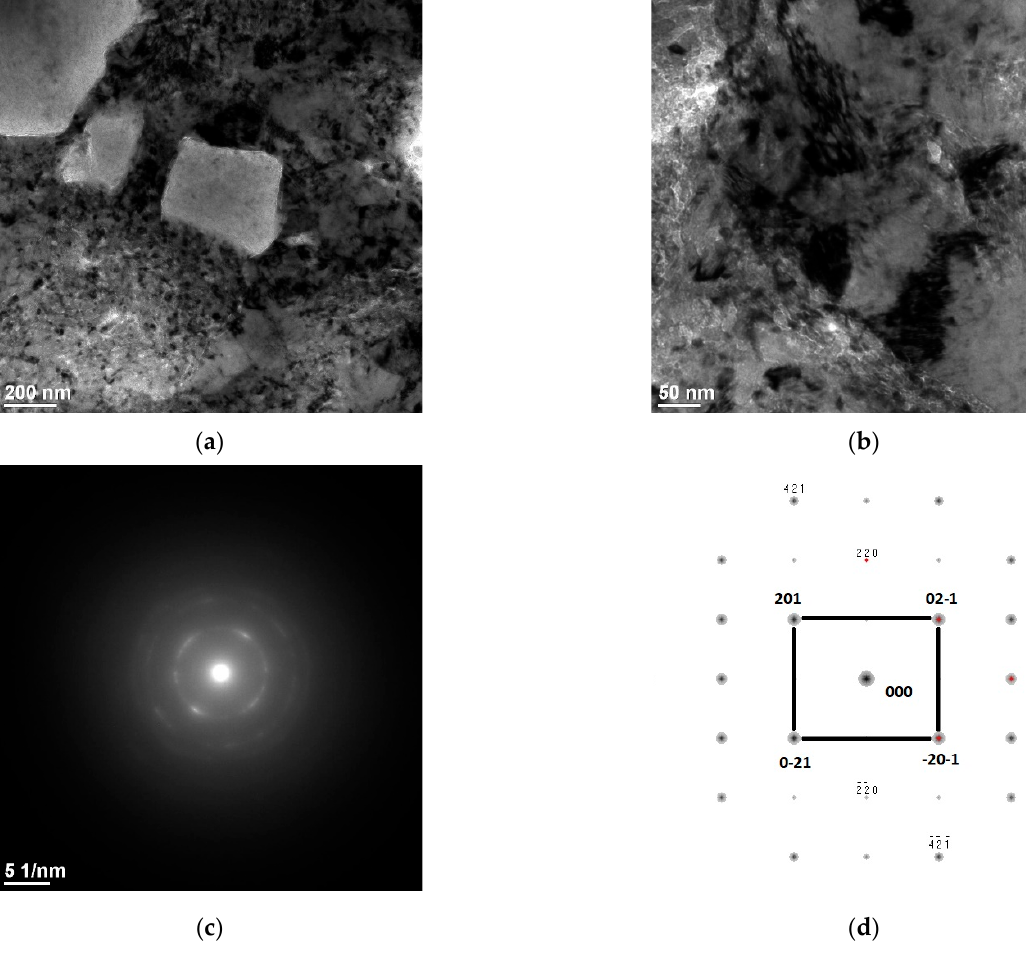
Figure 8. Results of the investigation of TEM microstructures, ( a ) bright field image Cr phases, ( b ) Cu matrix, ( c ) SAED pa tt ern from the areas in Figure 8a, ( d ) solution of the di ff raction pa tt ern pre- sented in Figure 8c.